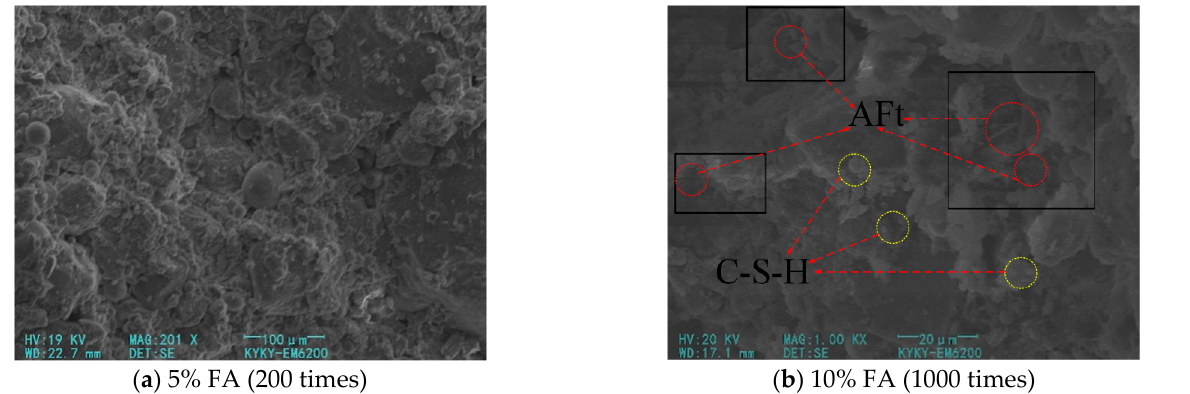
Figure 8. SEM pictures of modified soil with different FA content.